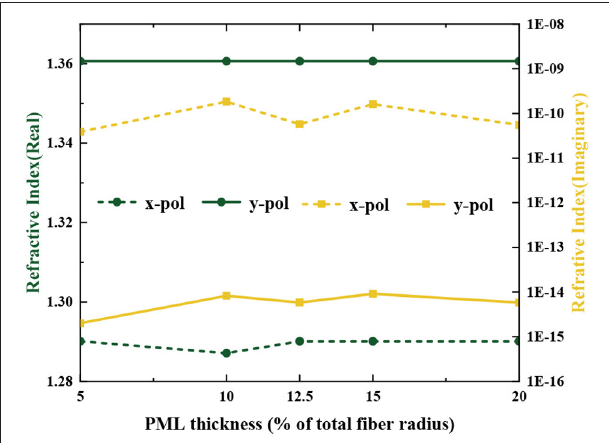
FIGURE 3 | Effective refractive index as a function of PML thickness for the proposed THz-PCF.